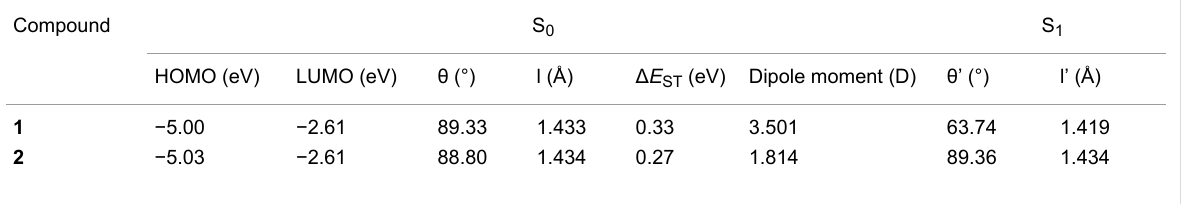
Table 2: The calculated HOMO, LUMO, twisting angles ( θ , θ ’), bond lengths (l, l’), Δ E ST and dipole moment in gas phase for S 0 and in solution for S 1 , from DFT and TD-DFT. Compound